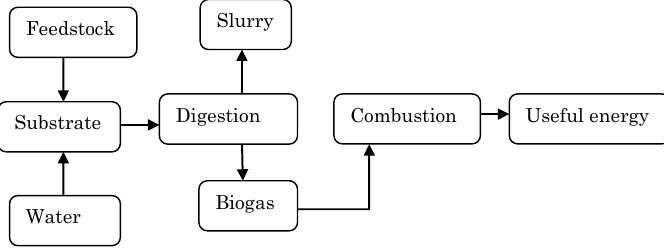
Figure 3. Schematic diagram of a biogas energy production system.